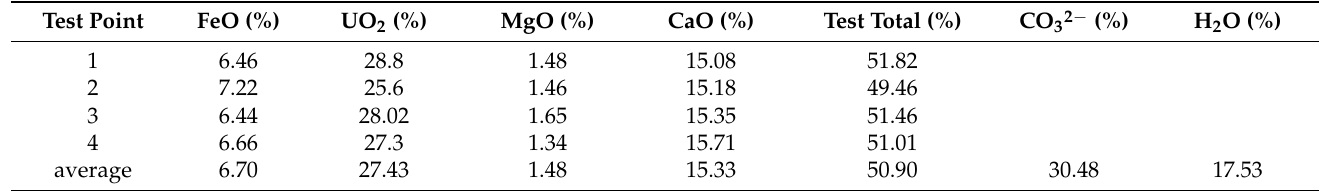
Table 2. Average chemical compositions of U-bearing carbonate minerals by